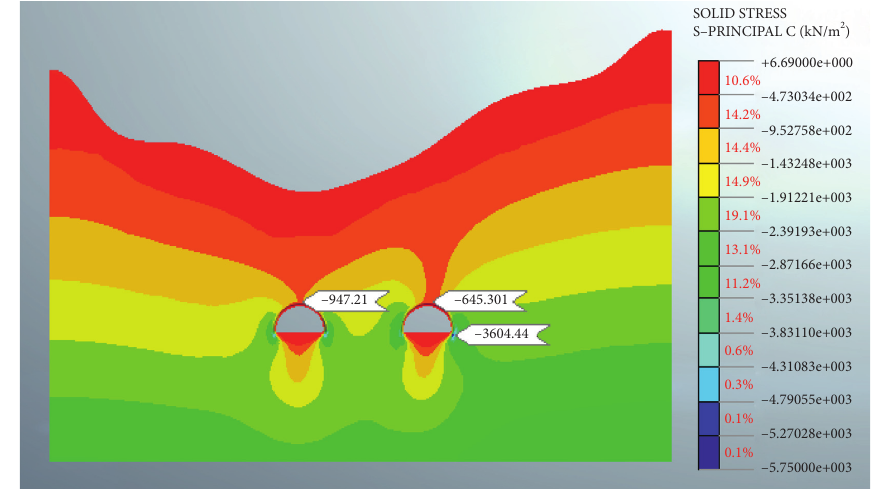
Figure 11: Large principal stress distribution of surrounding rocks in double-side guide pit method.